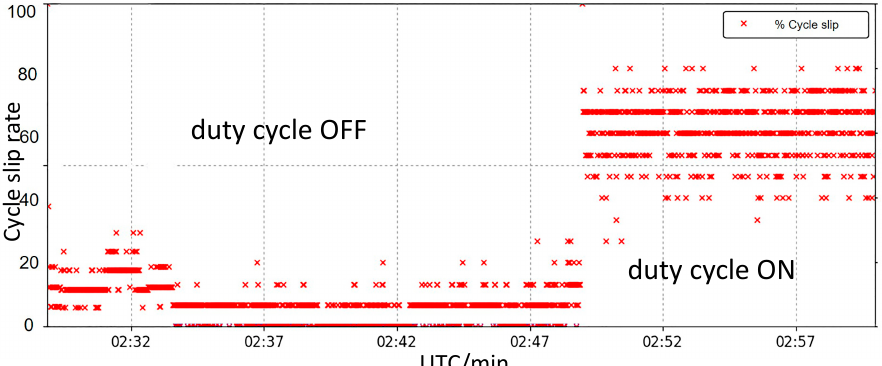
Figure 1. The cycle slip rate of 30-minute observations before and after turning on “duty cycle” (data collected by Mi 8 on October 7th, 2018 in the basketball court, Jilin University).